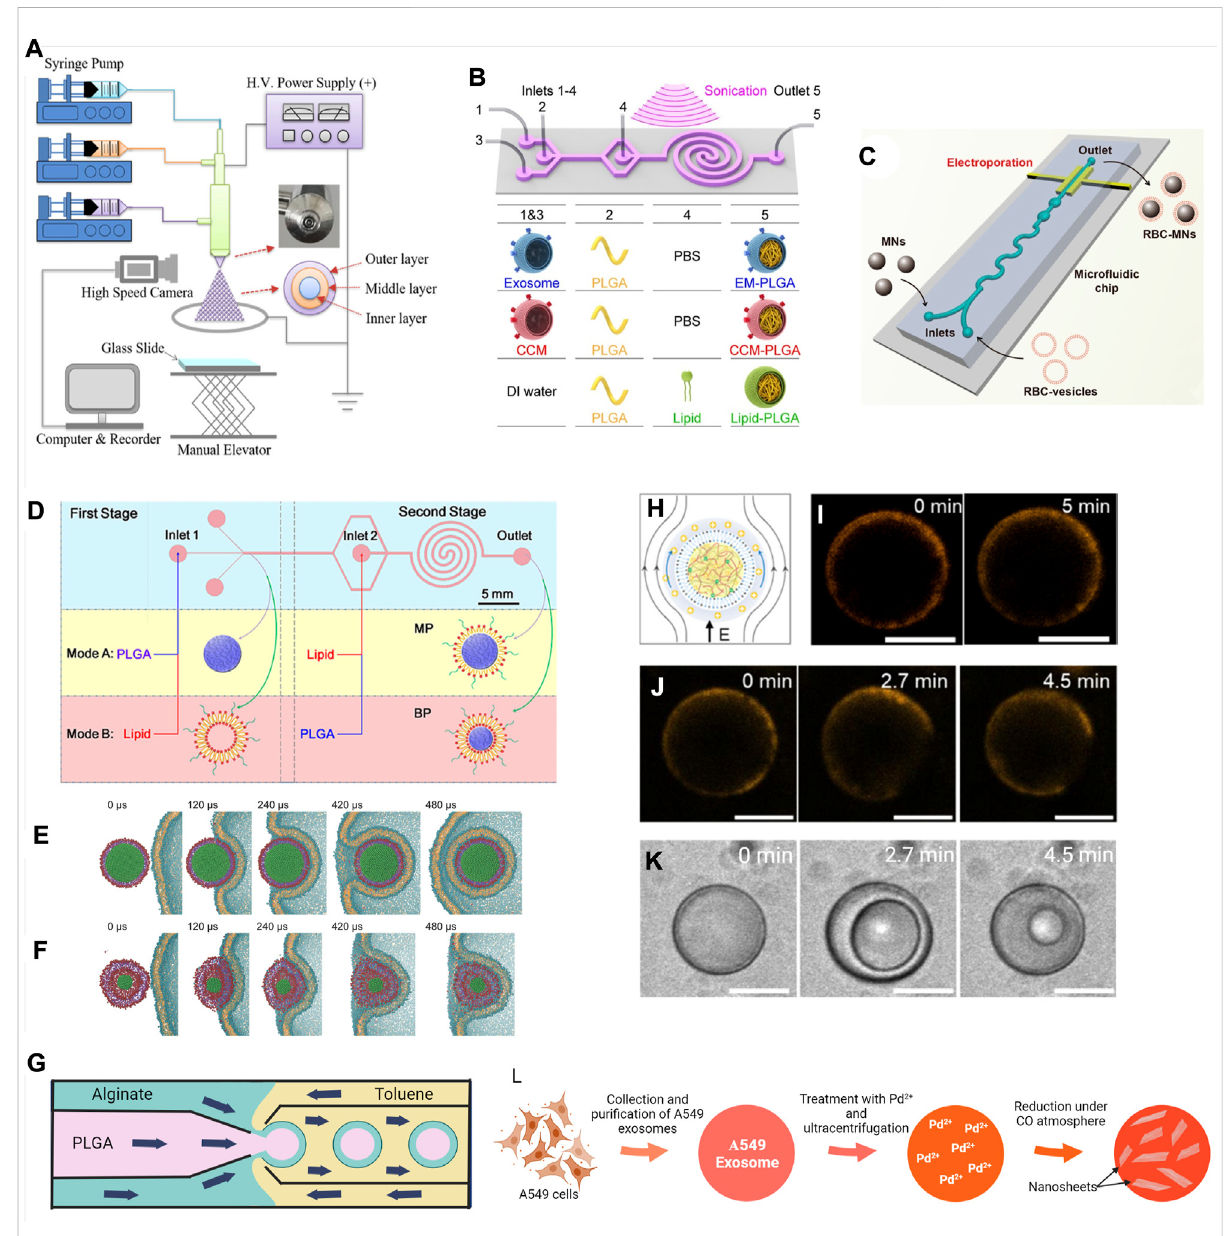
FIGURE 4 Surface modi fi cation techniques of micro- and nano-scale biomaterials. (A) Schematic diagram of a tri-axial electrospray system to produce multilayer core-shell particles. Reprinted with permission from Yao et al. (2020). Copyright 2020 American Chemical Society. (B) Schematic representation of the micro fl uidics sonication method for synthesis of the A549 exosome membrane (EM)-, cancer cell membrane (CCM)-, and lipid-coated PLGA NPsthroughthecombinedeffects ofsonicationand micro fl uidics. The micro fl uidics device consists ofonestraightchannel and one spiral channel connected with four inlets (inlets 1 – 4) and one outlet (outlet 5). The device is immersed in an ultrasonic bath, and the generated EM-PLGA NPs, CCM-PLGA NPs, and lipid-PLGA NPs are collected from outlet 5. Reprinted with permission from (C Liu et al., 2019). Copyright 2019 American Chemical Society. (C) Micro fl uidics electroporation-facilitated synthesis of RBCM-coated magnetic NPs (RBC-MNs). Reprinted with permission from Rao et al. (2017). Copyright 2017 American Chemical Society. (D) Schematic representation of the two-stage micro fl uidicschiptoproducemonolayer(MP)andbilayer(BP)lipidshellforPLGANPs.ReprintedwithpermissionfromZhangetal.(2015).Copyright 2015AmericanChemicalSociety.Useofmoleculardynamics(MD)simulationtodemonstratethein fl uenceofrigidityincellularuptakeof (E) MPand (F) BP. Reprinted with permission from Sun et al. (2015). Copyright 2014 WILEY-VCH Verlag GmbH & Co. KGaA, Weinheim. (G) Schematic diagram showing fabrication of PLGA – alginate core – shell microspheres using a multi-capillary micro fl uidics chip (Wu et al., 2013). (H) Illustration and (I) confocal fl uorescence images of fatty acid-coated coacervate droplets excited at 10 V/cm showing membrane (BODIPY 558/568 C12 — orange) slipped at the direction of green arrows. (J) BODIPY 558/568 C12 (orange) labeled fatty acid-coated coacervate droplets at 20 V/cm and (K) simultaneous repetitive cycles of vacuolization at that voltage. Scale bar, 10 μ m. Reprinted with permission from Jing et al. (2019). Copyright 2019 American Chemical Society. (L) Illustration of preparation of Pd-nanosheets encapsulated exosomes from A549 cells (Sancho-Albero et al.,